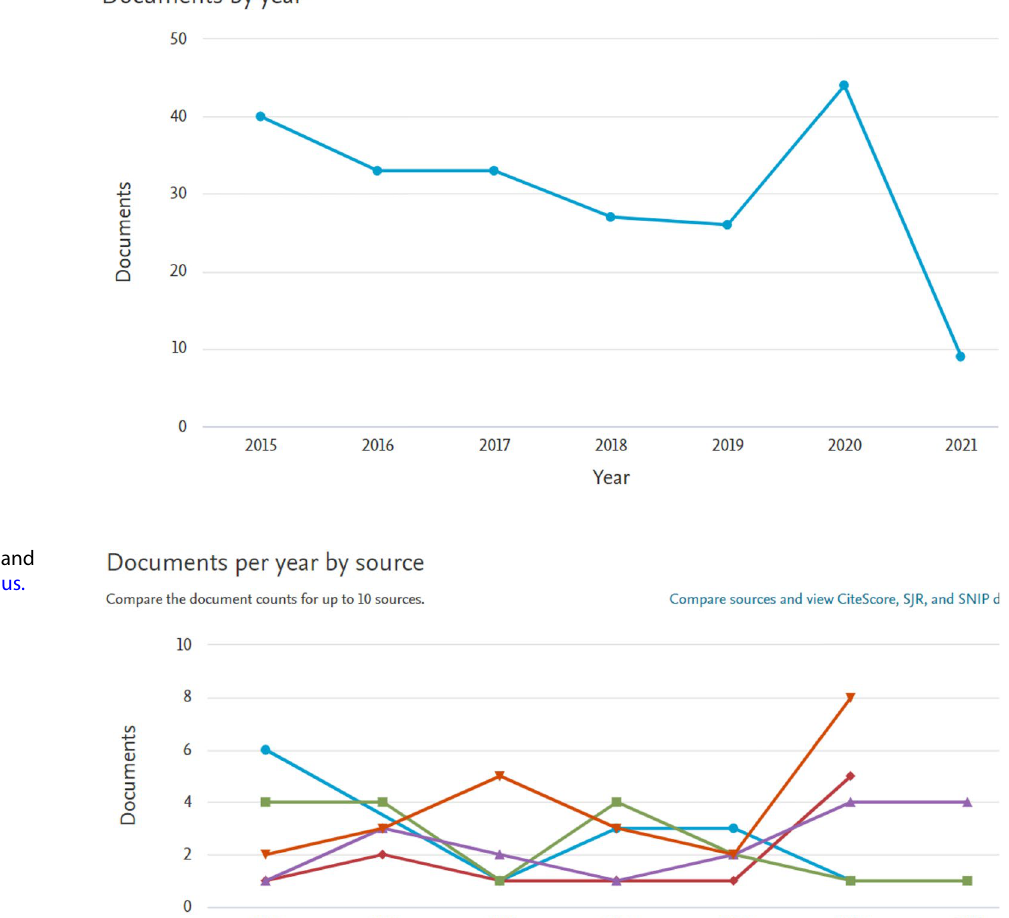
Fig. 4 Documents by Year of Publication (Source: www. scopus. com)